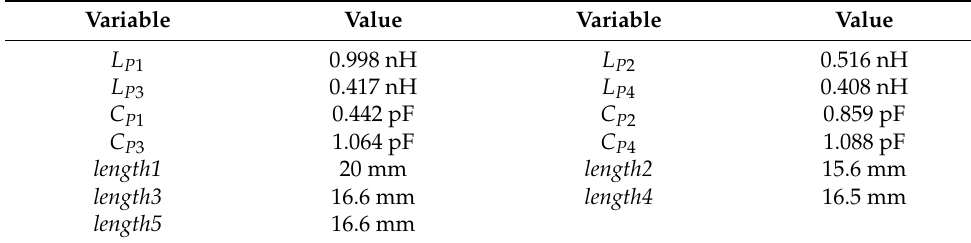
Figure 2. Modified equivalent circuit and its frequency response. ( a ) Circuit. ( b ) S 11 and S 21. Table 2. Calculated unknowns of Figures 1 and 2 for the required